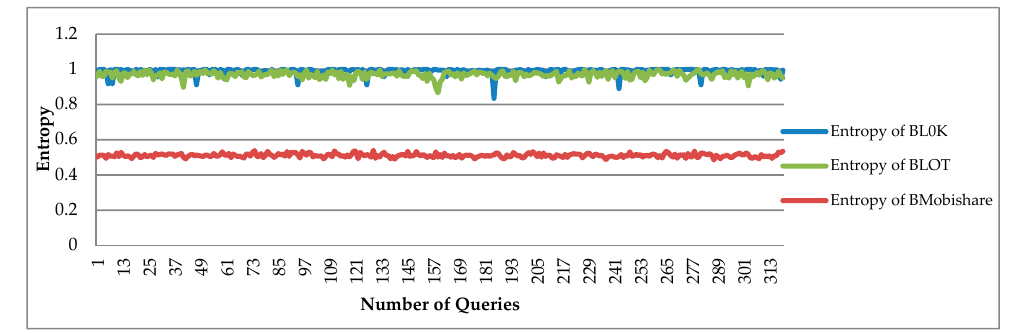
Figure 9. Performance entropy comparison of BL0K offers has better entropy than BLOT because the BLOT uses a lot of anonymous messages for increasing security, but in BL0K is achieved by using the zero-knowledge proof algorithm. No multiple or redundant information or queries sent on the network.